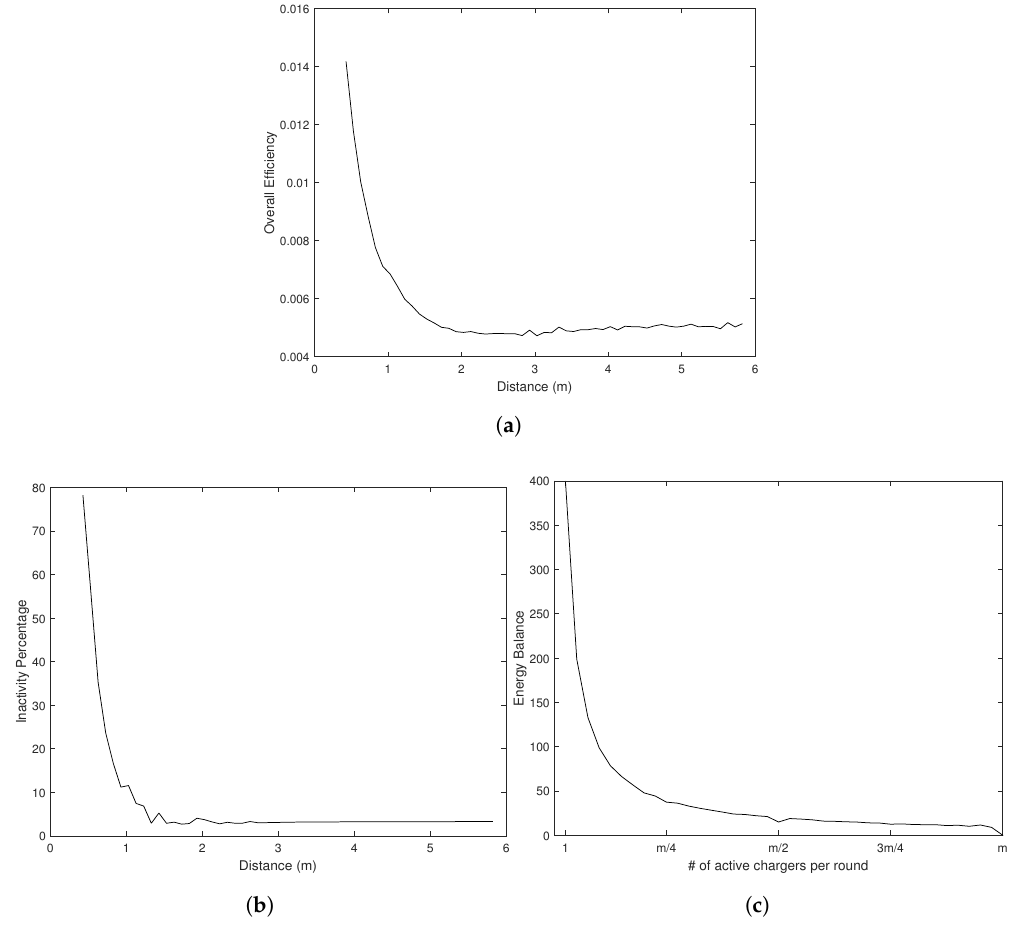
Figure 4. ( a ) Overall charging efficiency. ( b ) Percentage of inactivity. ( c ) Average energy balance. Percentage of inactivity. Choosing the right value for d threshold is essential for the performance of the Charging Oriented protocol. A low value will result in a very low probability for a network node to be within this distance from a charger and the protocol will spend several rounds without any active chargers. This can be observed in Figure 4b. We see that for lower values of the distance threshold, all the chargers remain inactive most of the